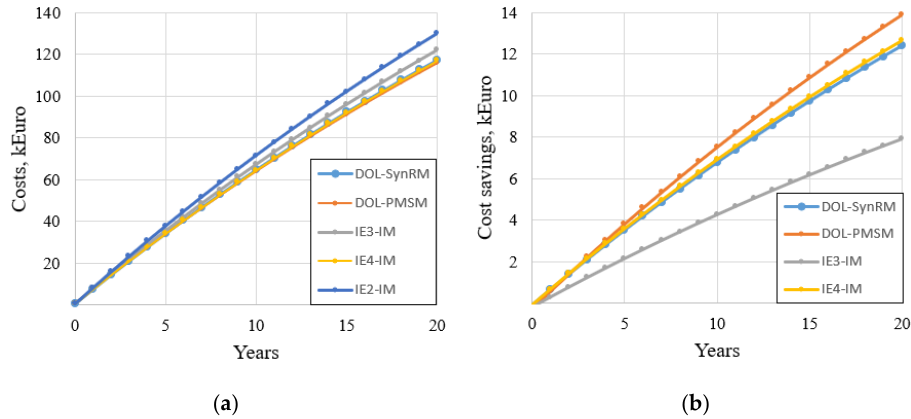
Figure 10. Time dependences for different motors (case 3): ( a ) cost vs. time; ( b ) cost savings compared with IE2 motor vs. time.